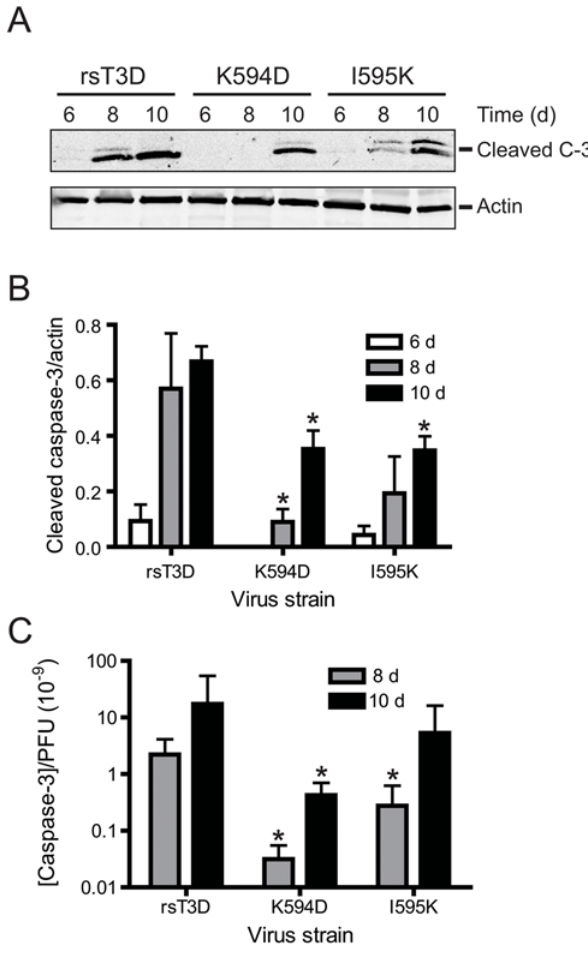
Figure 8. Q mutant viruses are apoptosis-defective in vivo. ND4 Swiss Webster mice were inoculated intracranially with 50 PFU of rsT3D or the indicated Q mutant. Brains from infected mice were resected at the times shown and homogenized by freeze-thaw and sonication. (A) Brain homogenates were resolved by SDS-PAGE and immunoblotted using an antiserum specific for activated caspase-3 (C-3) (upper panel). As a control for protein concentration, the blots were stripped and reprobed with an antibody specific for actin (lower panel). (B) Brain homogenates from five animals infected with each virus strain for the times shown were resolved by SDS-PAGE and immunoblotted using antisera specific for either activated caspase-3 or actin. Pixel intensities of activated caspase-3 and actin bands were quantified by densitom- etry. Results are expressed as the mean ratio of activated caspase-3 band intensity to that of actin. Error bars indicate SEM. *, P , 0.05 as determined by Student’s t test in comparison to rsT3D at each time point. (C) For each brain homogenate, the cleaved caspase-3/actin ratio obtained by immunoblot analysis was divided by the virus titer. Results are expressed as the mean activated caspase-3 concentration/PFU. Error bars indicate SEM. *, P , 0.05 as determined by Student’s t test in comparison to rsT3D at each time